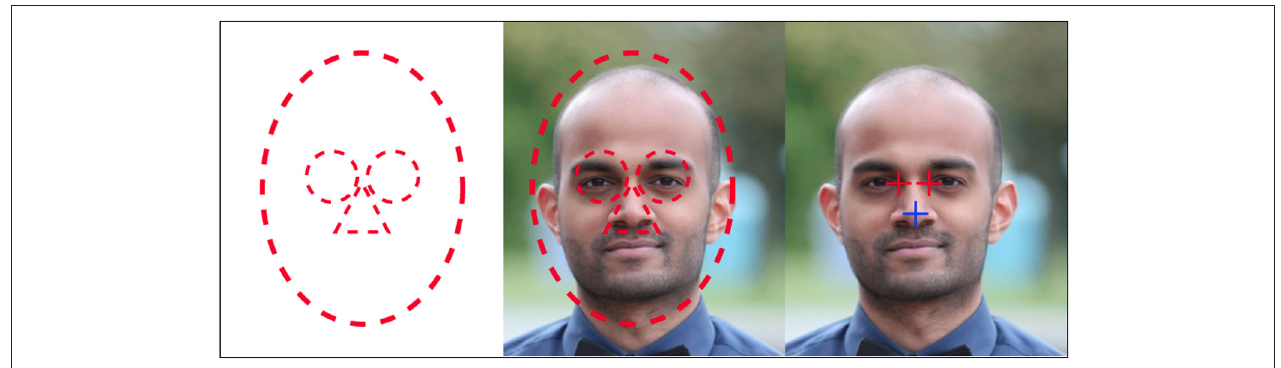
FIGURE 7 | Idea behind the max-min template